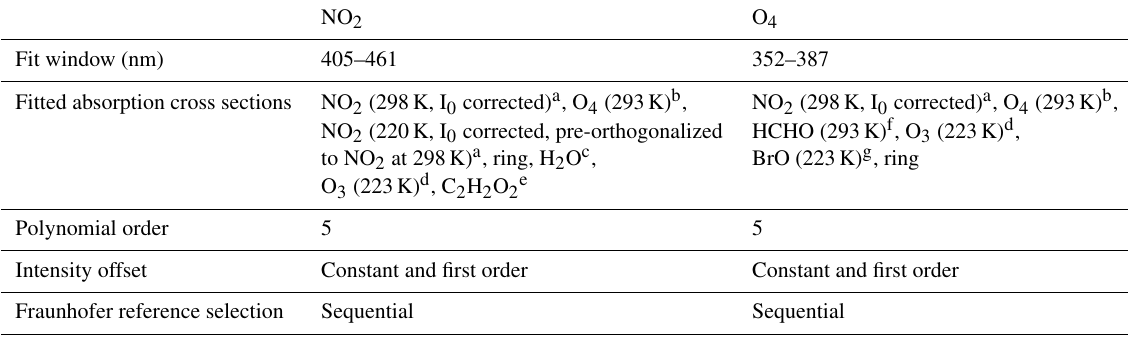
Table C1. Fit settings chosen for MAX-DOAS spectral analyses.